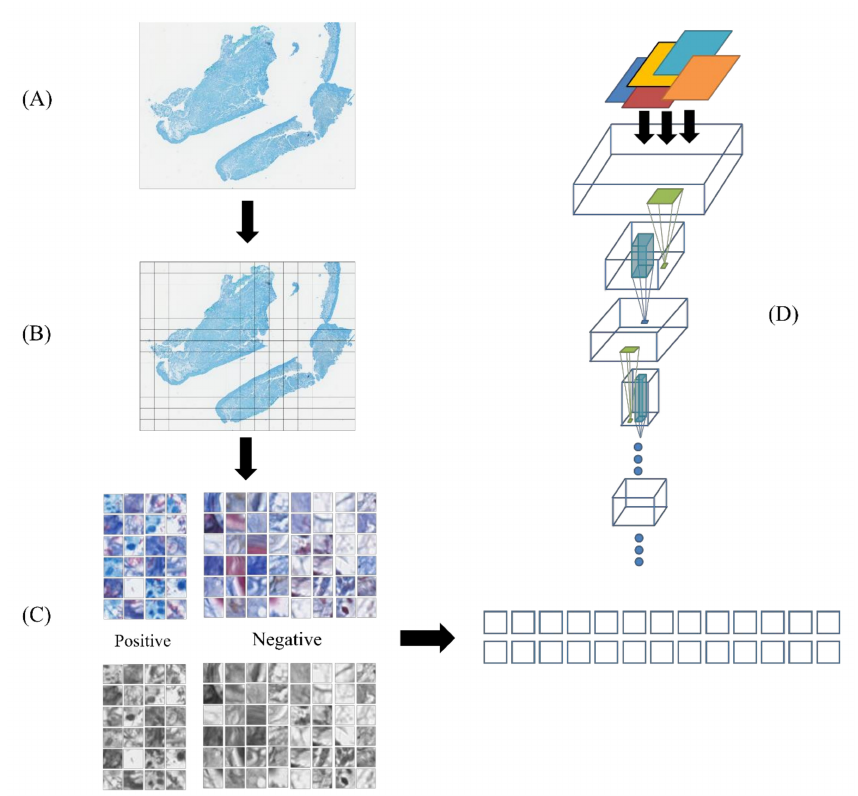
Figure 5. The computer-aided diagnosis workflow. ( A ) A whole-slide pathology image. ( B ) Cropped samples fitting to mycobacteria bacilli (20 × 20 pixels) ( C ) Positive and negative sample selection. ( D ) Transferred deep convolutional neural network (DCNN) model.